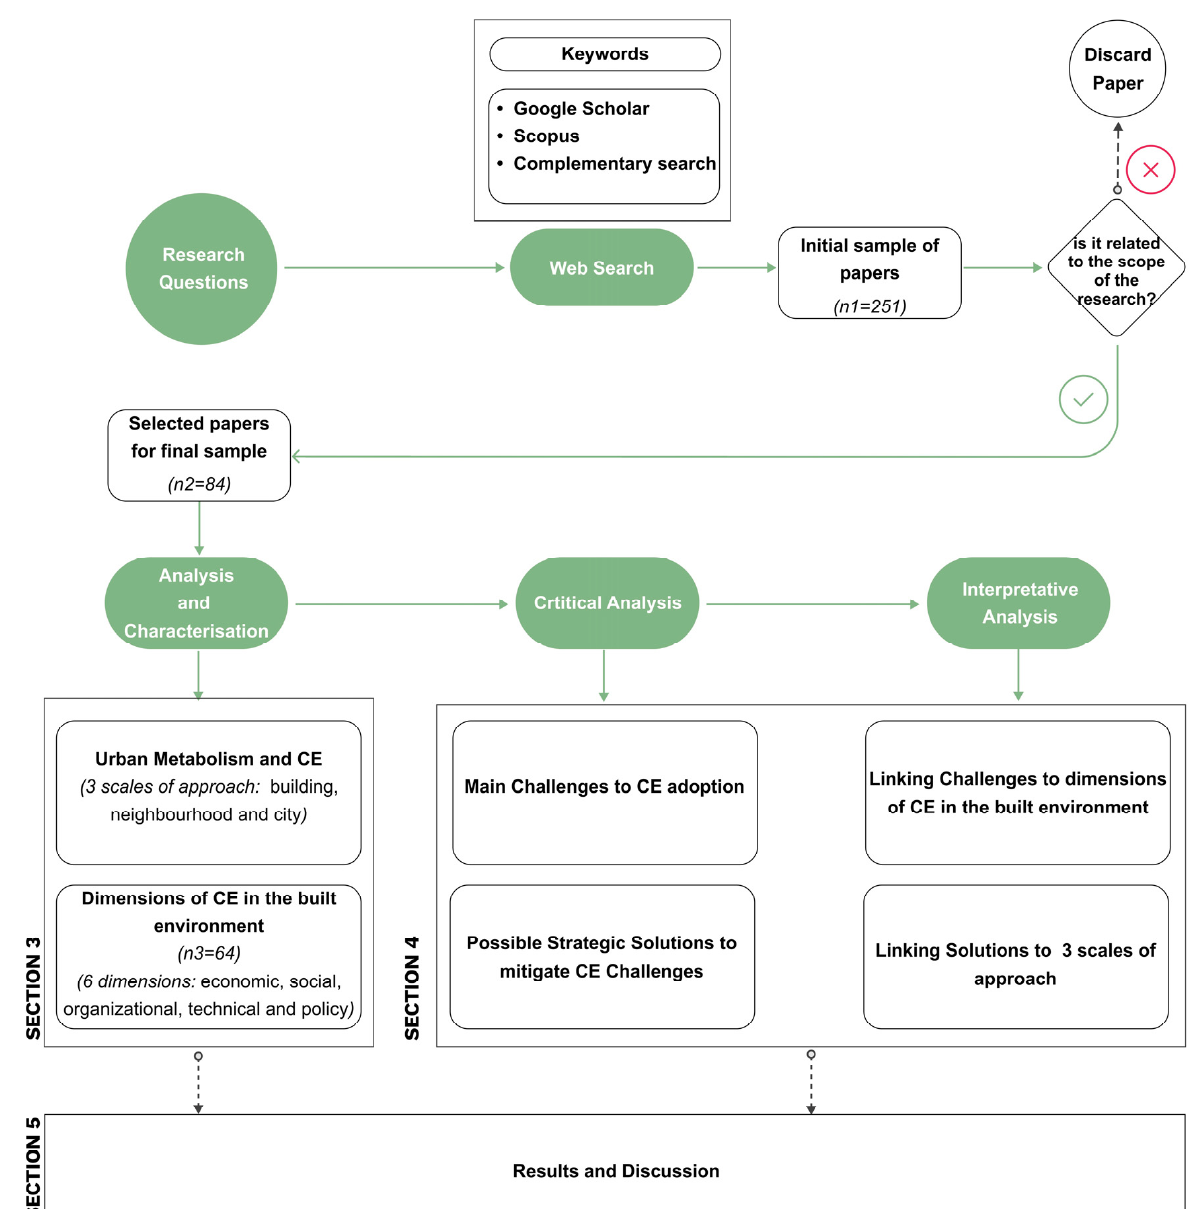
Figure 1. Schematic representation of the research methodology.